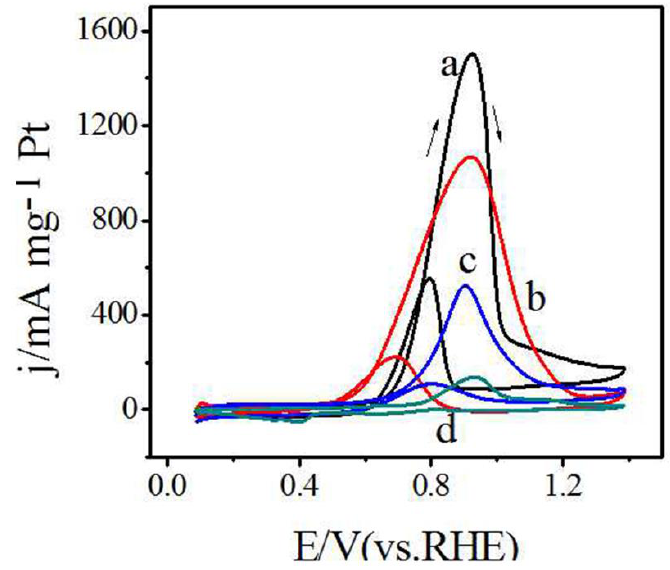
Figure 5. Cyclic voltammetry in 1.0 M CH 3 OH + 1.0 M NaOH: Pt-Bi (Bi 2 O 3 )/GNs (PVP) ( a ), 30% PtRu/C-JM ( b ), Pt/GNs (PVP) ( c ) and Pt-Bi (Bi 2 O 3 )/GNs ( d ), at 10 mV s −1 .